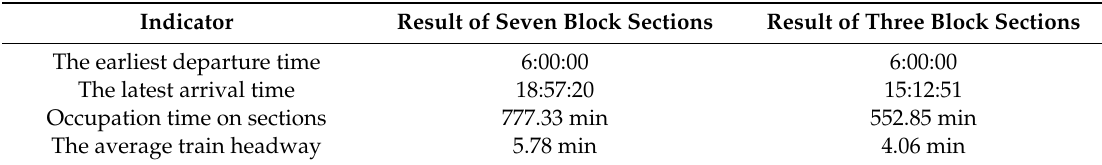
Table 9. Comparison of relevant indicators when di ff erent interval distance.